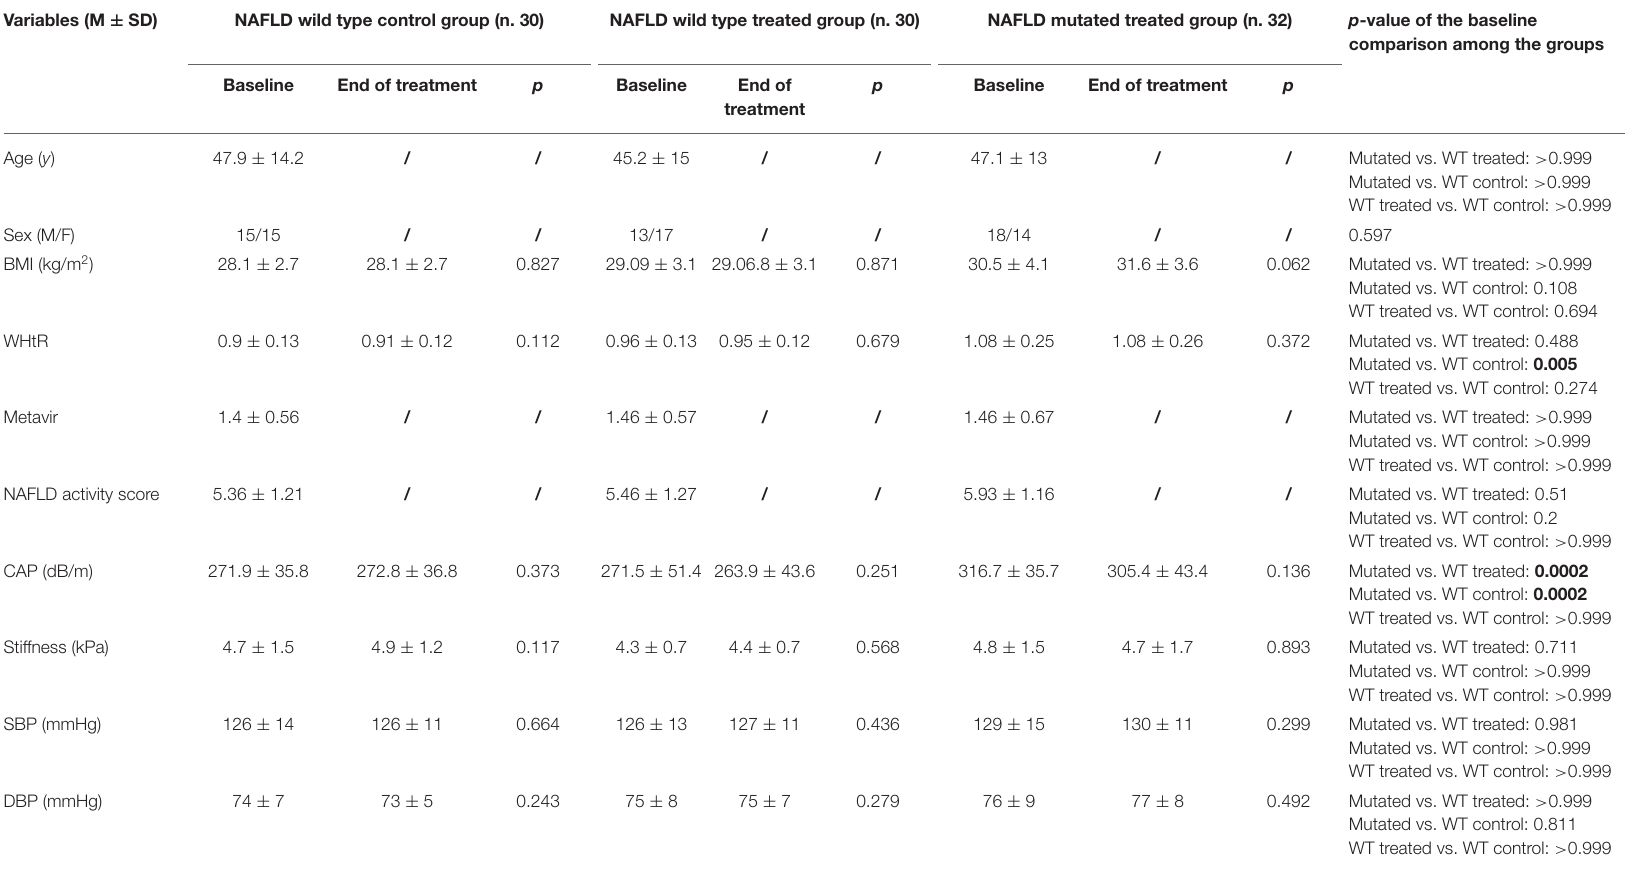
TABLE 1 | Effect of the therapy on clinical, biochemical, thiobarbituric acid reactive substance, Fibroscan ® and controlled attenuation parameter assessment among the three study groups. Variables (M ± SD) NAFLD wild type control group (n. 30) NAFLD wild type treated group (n. 30) NAFLD mutated treated group (n. 32) p -value of the baseline